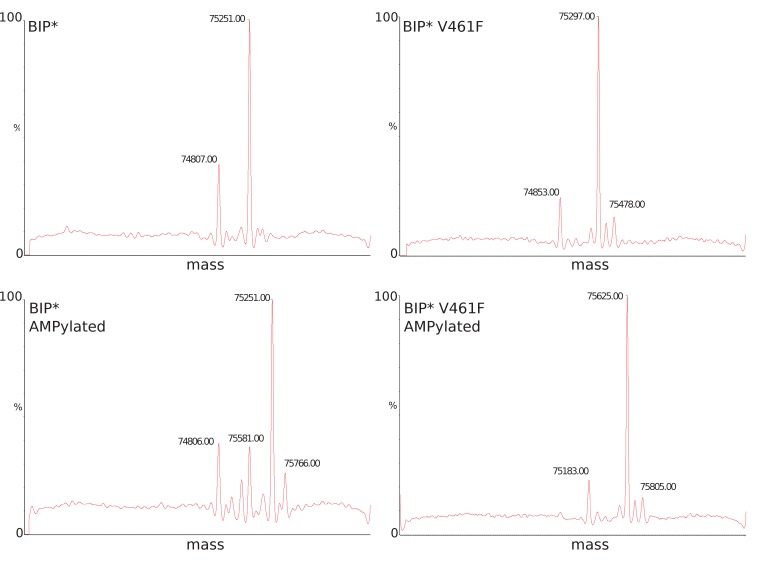
LC-MS data for molecular mass determination of unmodified (panels A-B) and AMPylated (panels C-D) BiP. Molecular mass difference of ~330 Da as reported before (Preissler et al., 2015) corresponds to modification by AMPlation. An additional peak at ±180 Da corresponds to α-N-Glucosylation of the His-tag.